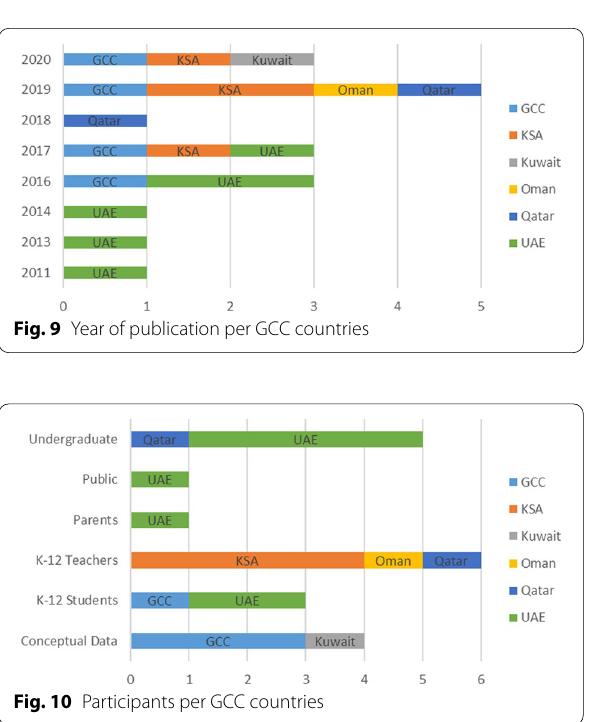
Fig. 12 Level of education per GCC